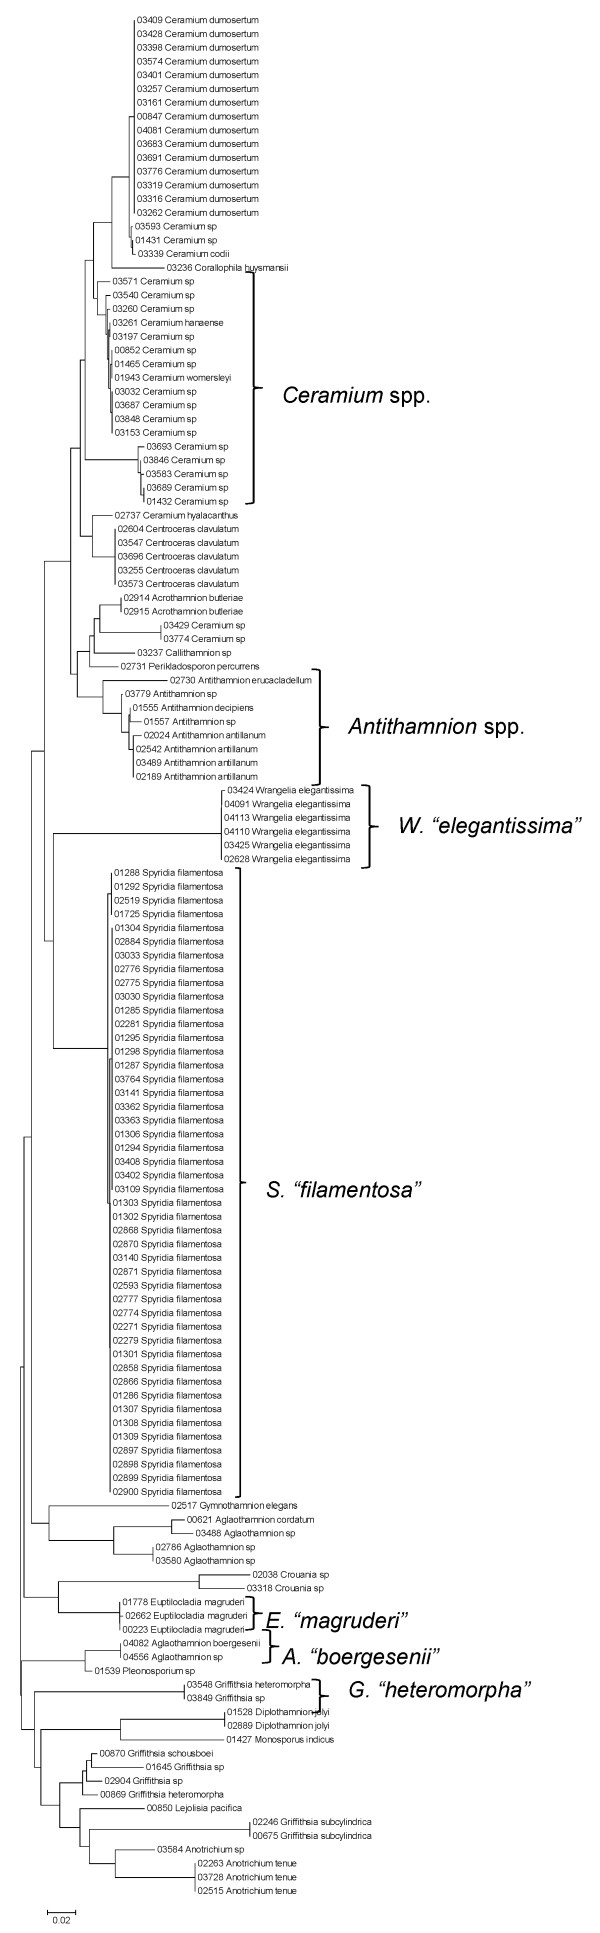
Neighbor-joining tree of LSU sequences of the families Callithamniaceae, Ceramiaceae, Spyridiaceae and Wrangeliaceae of the order Ceramiales. Sequence diversity based on the LSU nuclear marker for surveyed Rhodophyta specimens belonging to the families Callithamniaceae, Ceramiaceae, Spyridiaceae and Wrangeliaceae of the order Ceramiales. Neighbor-joining tree is based on the Maximum Composite Likelihood nucleotide model in MEGA 4.0. Scale bar = substitutions per site.